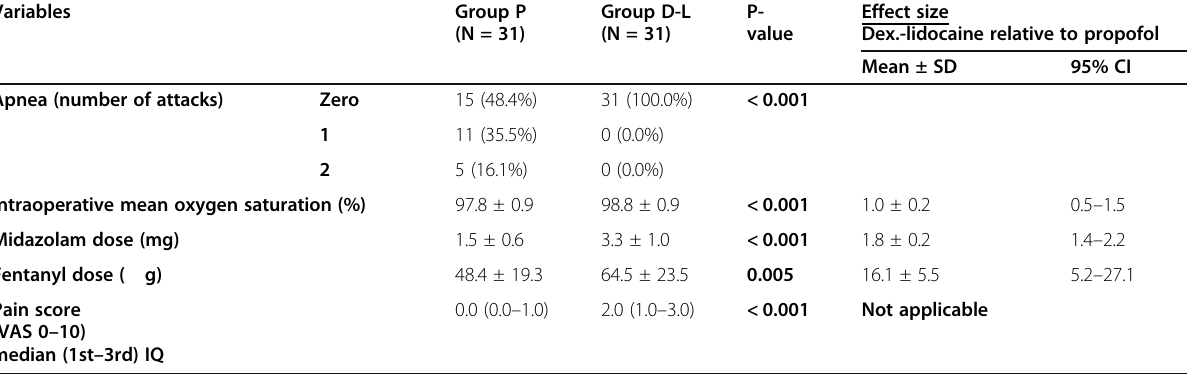
Table 3 Illustration of apnea, oxygen saturation, midazolam, and fentanyl requirements and pain scores